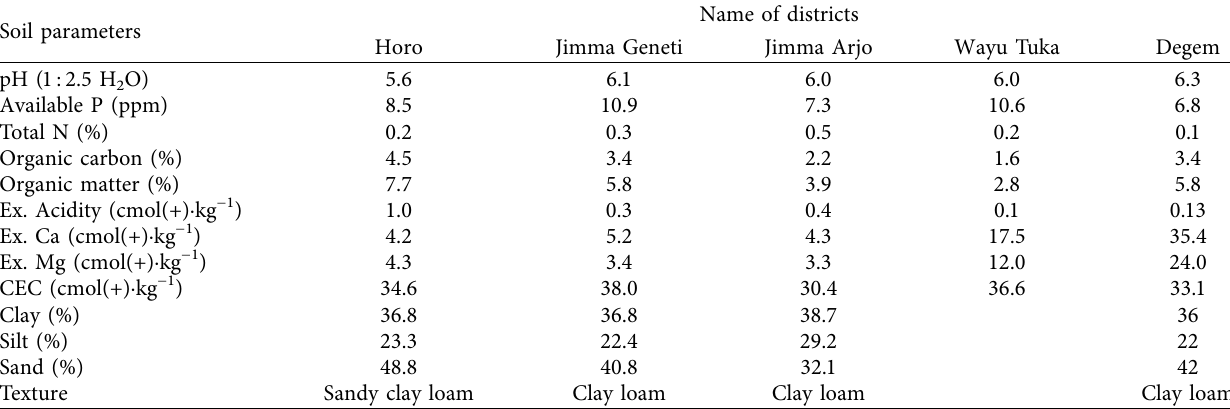
Table 2: Soil physico-chemical characterization of the study sites before planting in Horo, Jimma Geneti, Jimma Arjo, Wayu Tuka, and Degem districts in the 2020 season, Oromia, Ethiopia. Soil